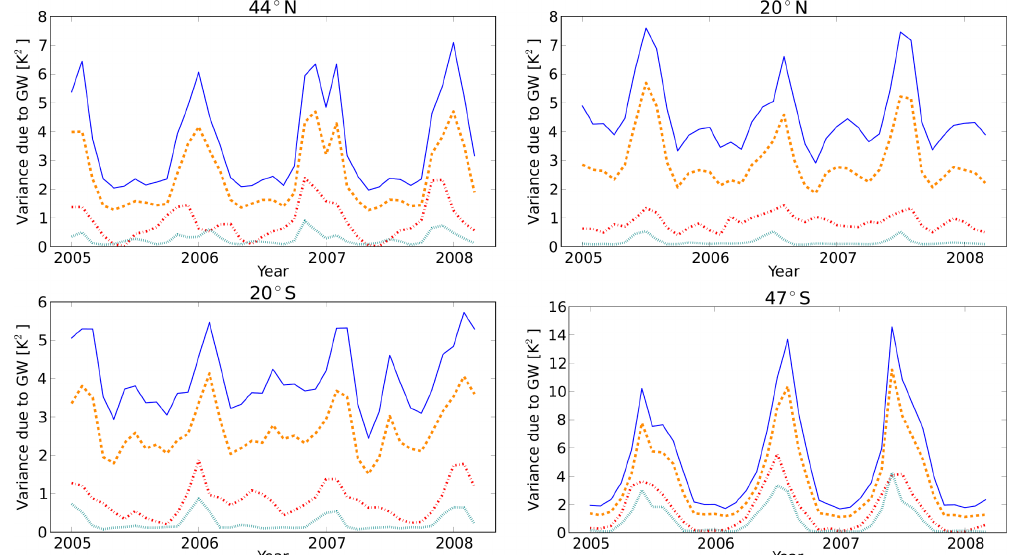
Figure 13. Time series of gravity wave variances at 42km altitude and different latitudes (see plot titles). Red dash-dotted lines: AIRS high- resolution retrieval. Blue lines: HIRDLS. Orange dashed lines: HIRDLS with MEM/HA. Cyan dotted lines: HIRDLS filtered with AIRS sensitivity function. Note that filtered HIRDLS data are scaled by a factor of